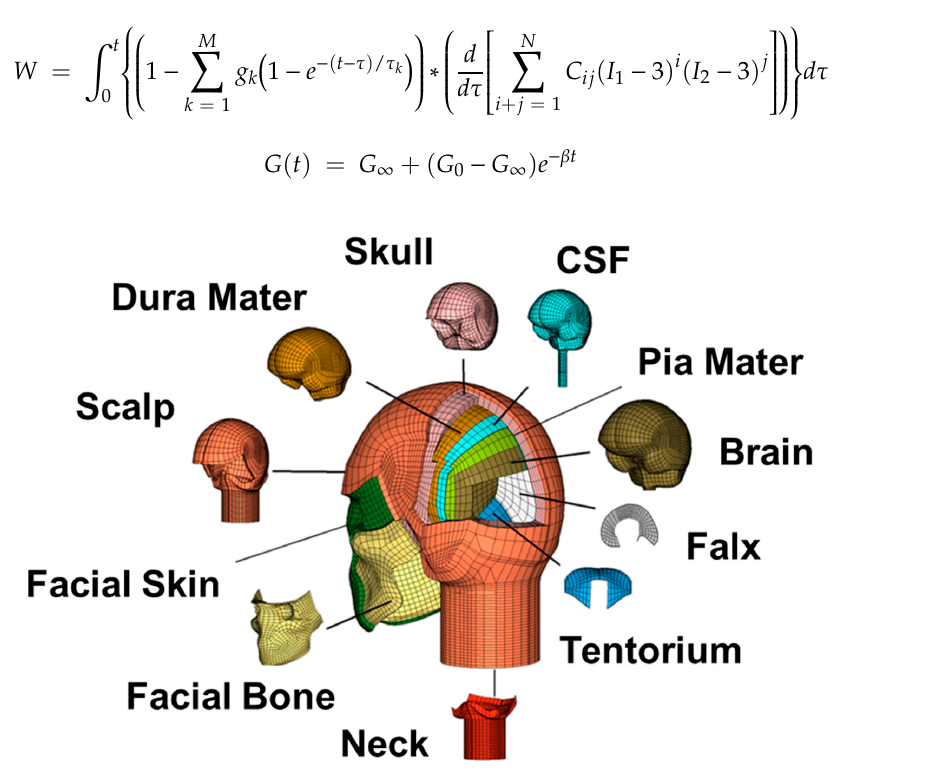
Figure 1. The finite element (FE) head model used in this study includes the main components of the human head [44]. Table 1. Head model component properties and mechanical properties